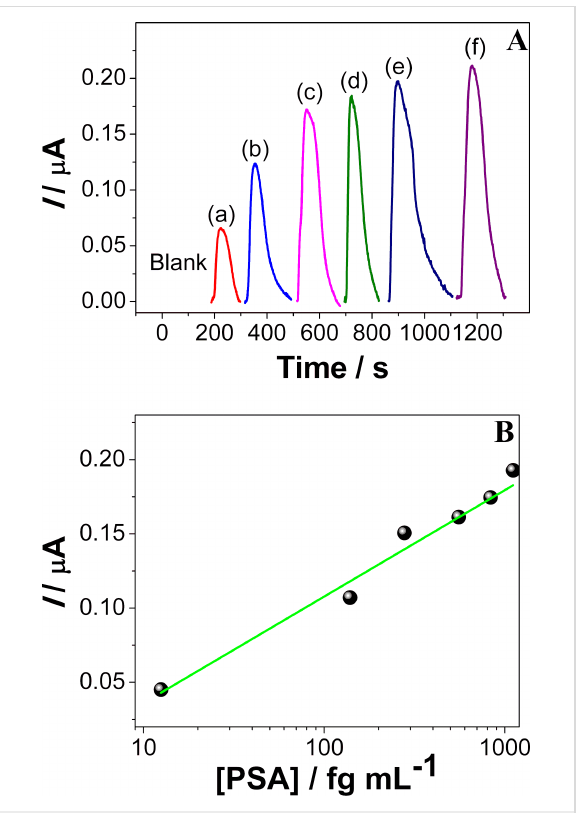
Figure 1: (A) Amperometric responses for a blank solution and PSA solutions at concentrations of: (a) 12.5, (b) 138, (c) 277, (d) 555, (e) 823 and (f) 1111 fg·mL − 1 prepared in a calf serum medium. (B) An- alytical curve for PSA standards, using MNPs, anti-Ab 1 and anti-Ab 2 at a concentration of 10 μ g·mL − 1 , and concentrations of 10 µmol·L − 1 and 1 μ mol·L − 1 for HQ and H 2 O 2 , respectively.